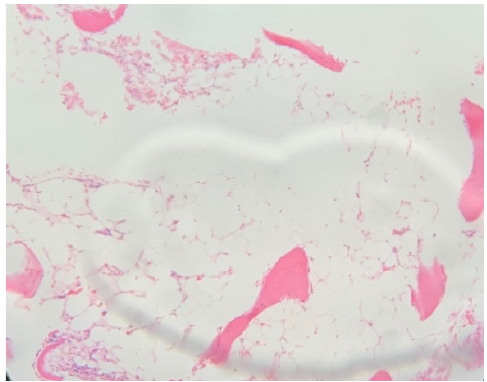
Figure 2. Microscopic picture of bone marrow tissue. Table 6. Bone Marrow Failure Syndromes